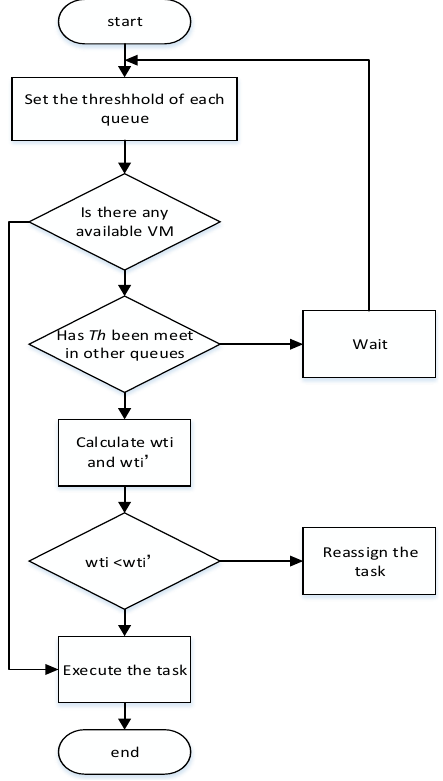
Figure 3. Procedure of Algorithm 3.